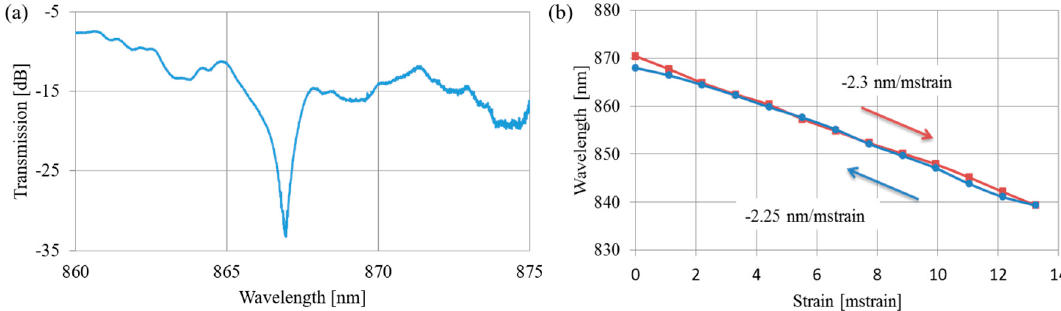
Figure 9. ( a ) Transmission of Long Period Grating, and ( b ) wavelength change induced by increasing and decreasing strain; image from [113].